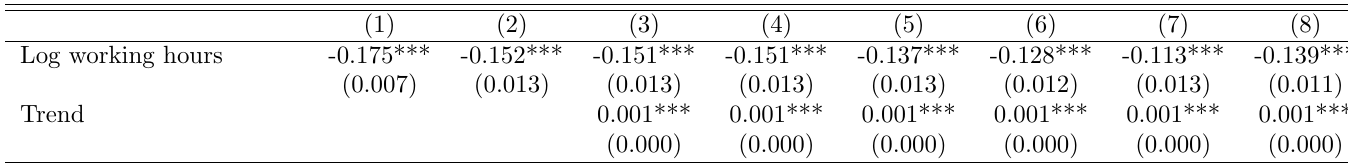
Table 3: Relationship between productivity and working time at the day